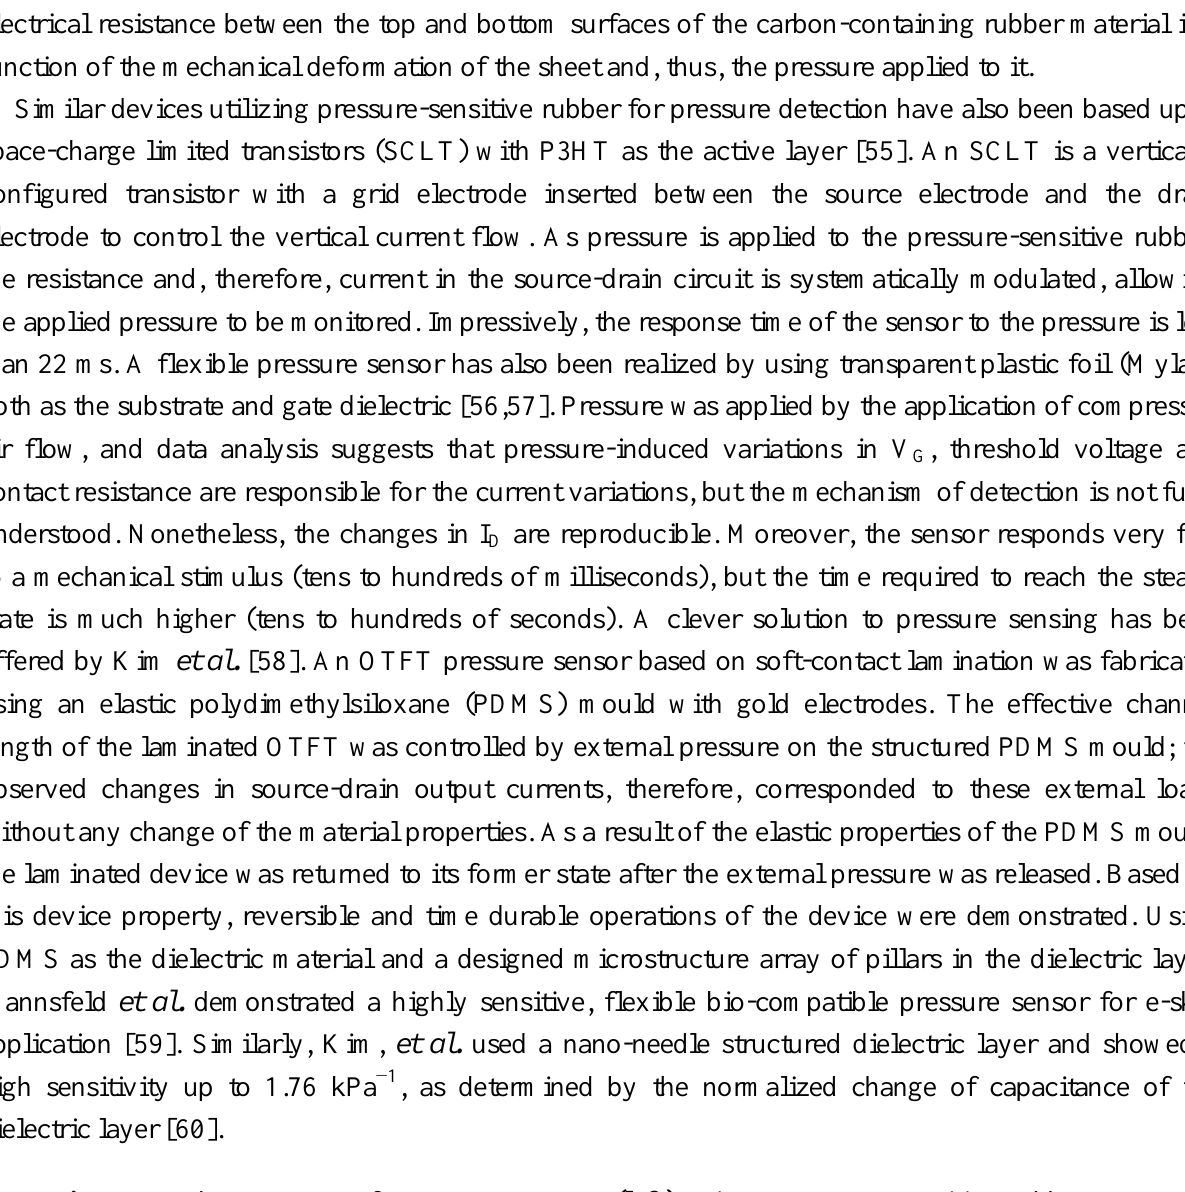
Figure 6. The structure of a pressure sensor ( left ) using a pressure-sensitive rubber as a transducer. Shown also is the thermal sensor ( right ) reported in the same